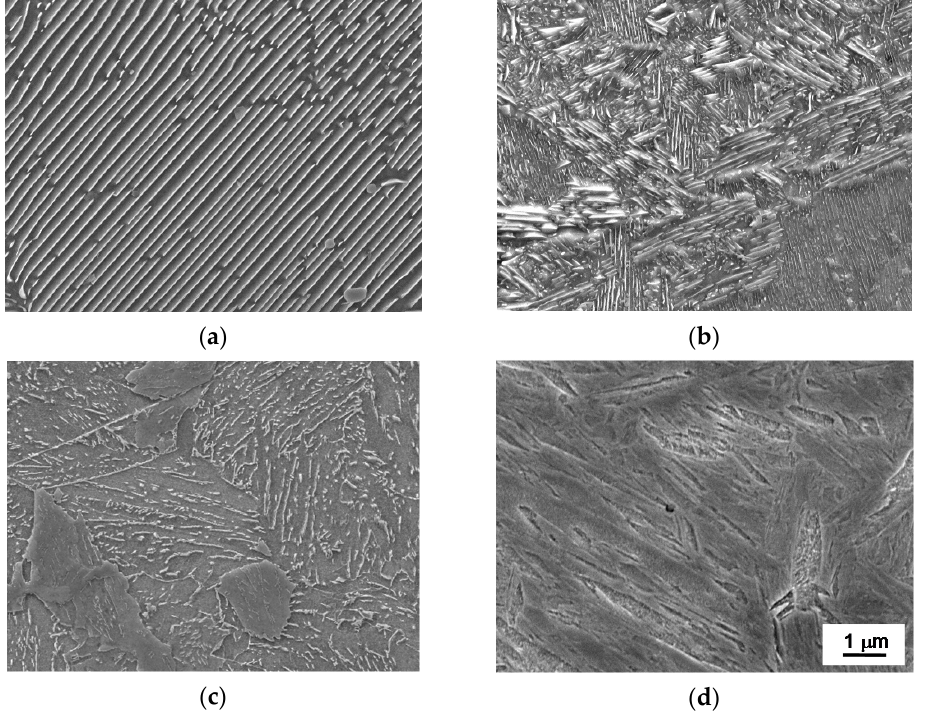
Figure 2. Microstructures obtained by quick cooling from 850 °C to the transformation temperature, and subsequent holding at the transformation temperature to promote isothermal phase transformation. Initial coarse pearlite (phase transformation temperature = 700 °C) ( a ), initial fine pearlite (phase transformation temperature = 630 °C) ( b ), initial bainite (phase transformation temperature = 500 °C) ( c ), and martensite obtained after quenching from 850 °C ( d ).